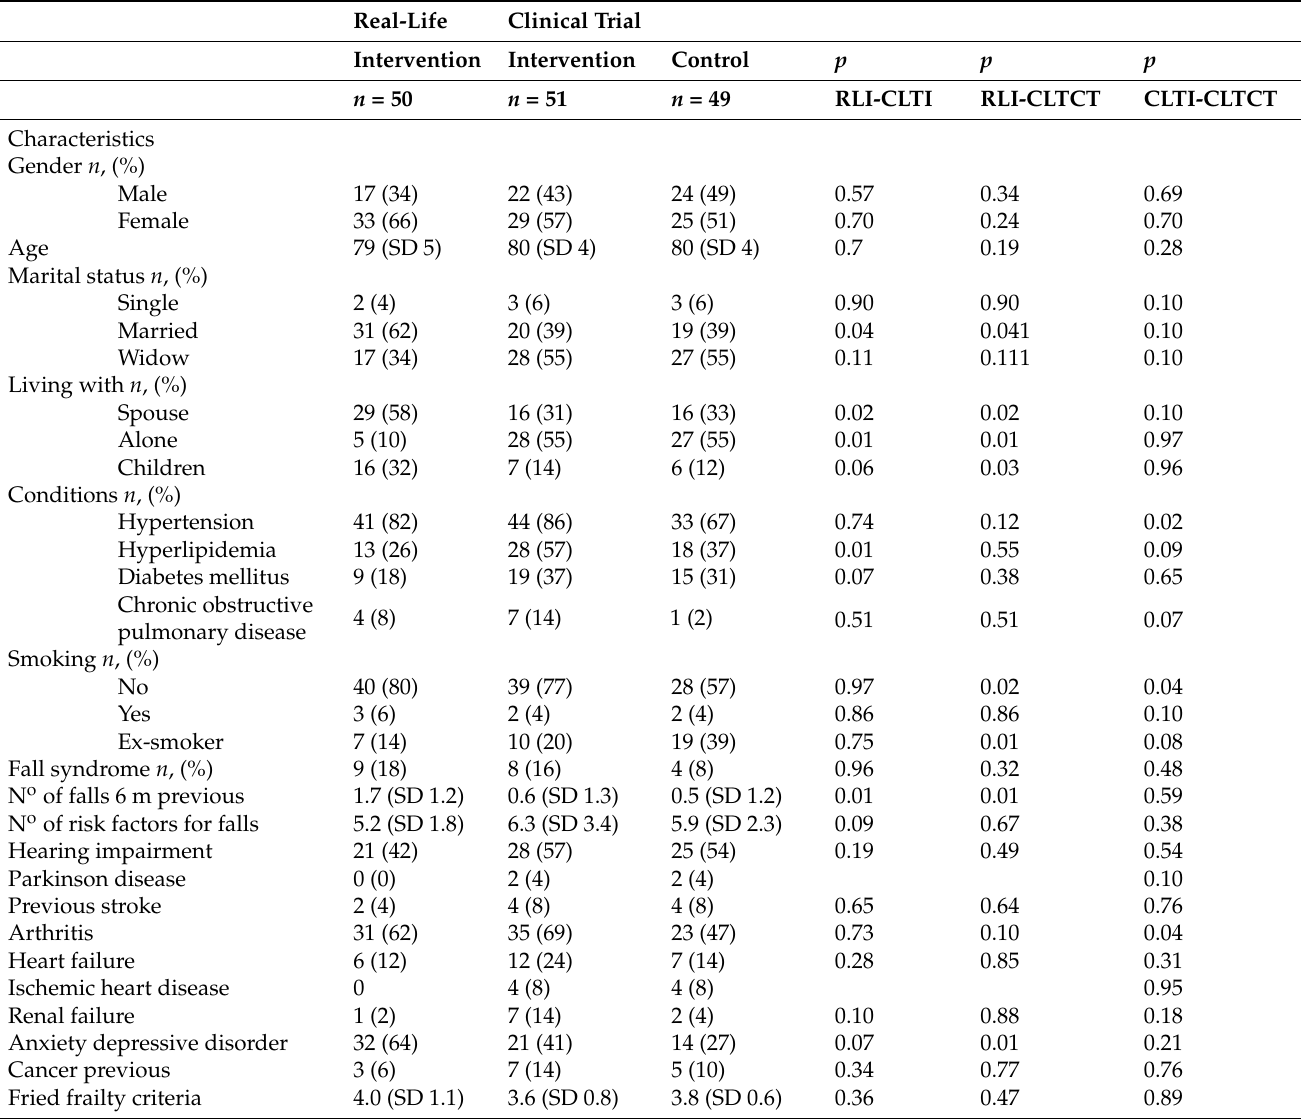
Table A1. Baseline characteristics of the